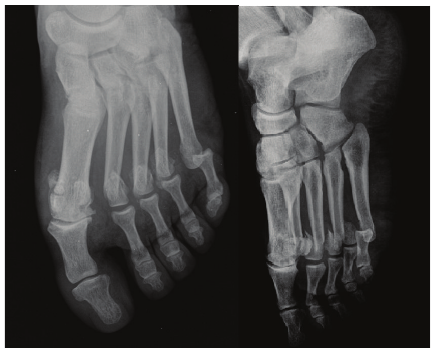
Figure 1: The X-ray of the patient on first examination.